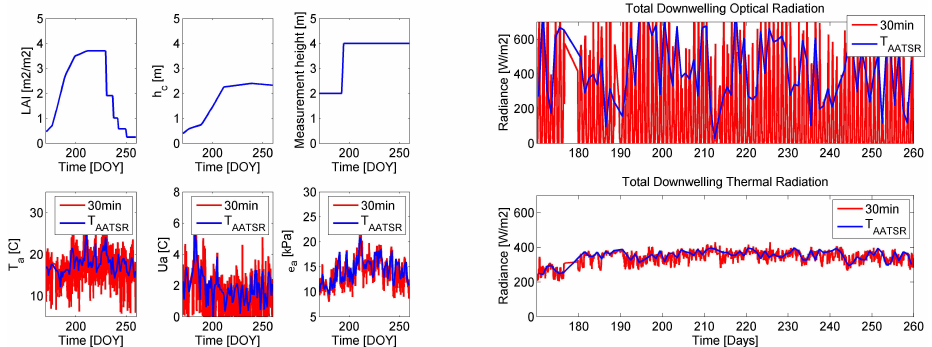
Fig. 2. SCOPE input parameters and variables measured at the experimental site during 2002. In the top left panel the surface parameters are shown. In the bottom left panel the atmospheric driving variables. In the right panel the incoming optical and thermal radiance data are shown. The red lines depict half hourly in situ measured data, and the blue lines depict the values at AATSR overpass time ( T aatsr ) .